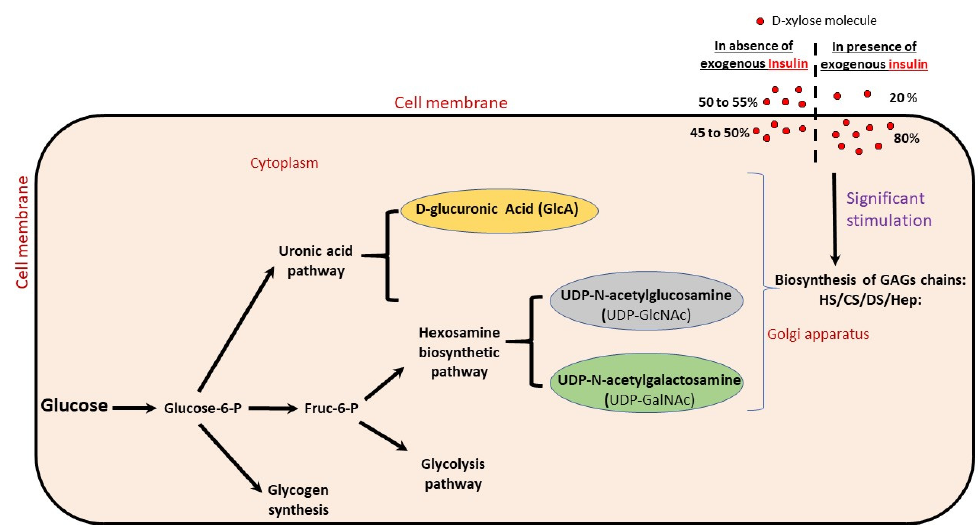
Figure 1. Distribution or utilisation of glucose metabolites in the cell.